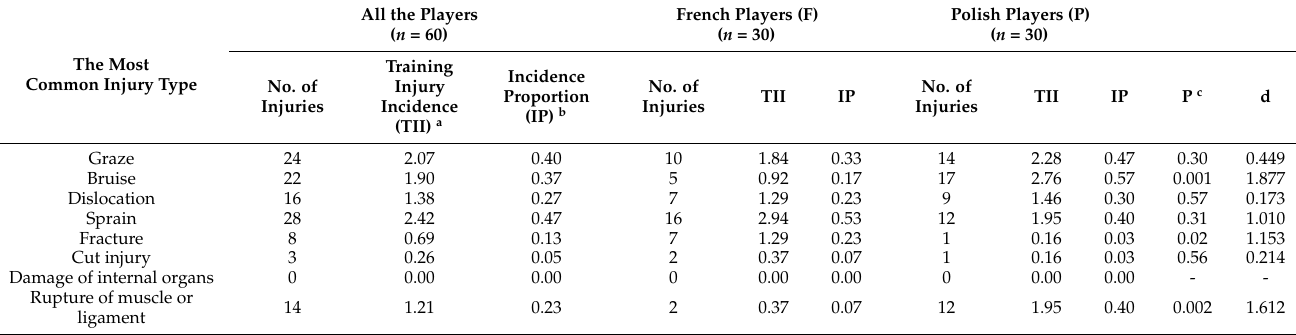
Table 2. Rugby injuries reported by rugby players ( n = 60) by